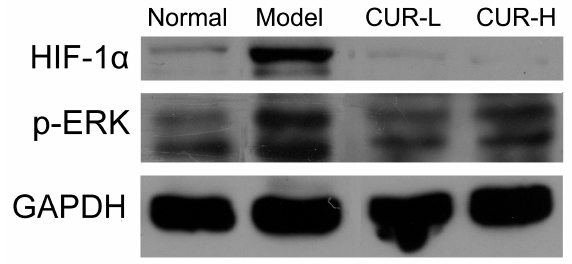
Figure 4. Effects of curcumin on the expression of HIF-1 α and p-ERK in liver tissues. The protein used in this experiment was extracted from the liver tissues of rats: ( A ) HIF-1 α ; ( B ) p-ERK. Data were expressed as mean ± SD. * p < 0.05, ** p < 0.01 compared with normal group, # p < 0.05, ## p < 0.01 compared with model